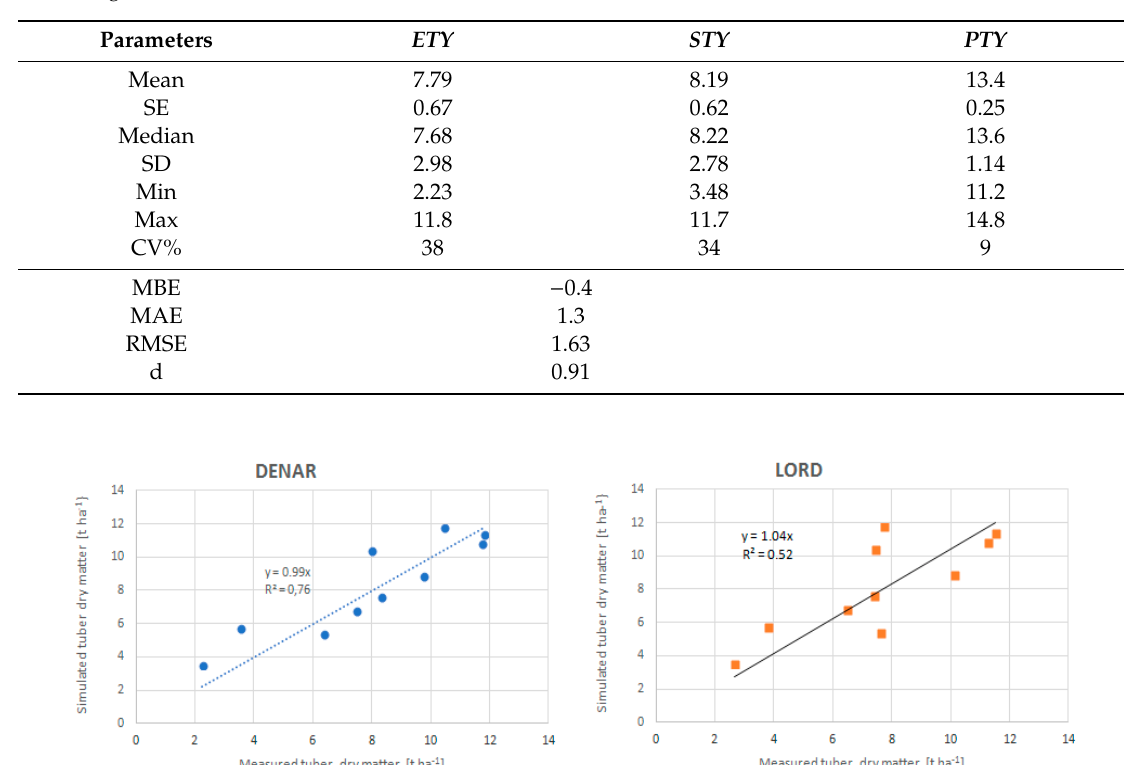
Table 8. Yield simulation errors (average for cultivars) for modified calibration of the WOFOST model. MBE—mean bias error; MAE—mean absolute error; RMSE—root mean square error; d—index of agreement.